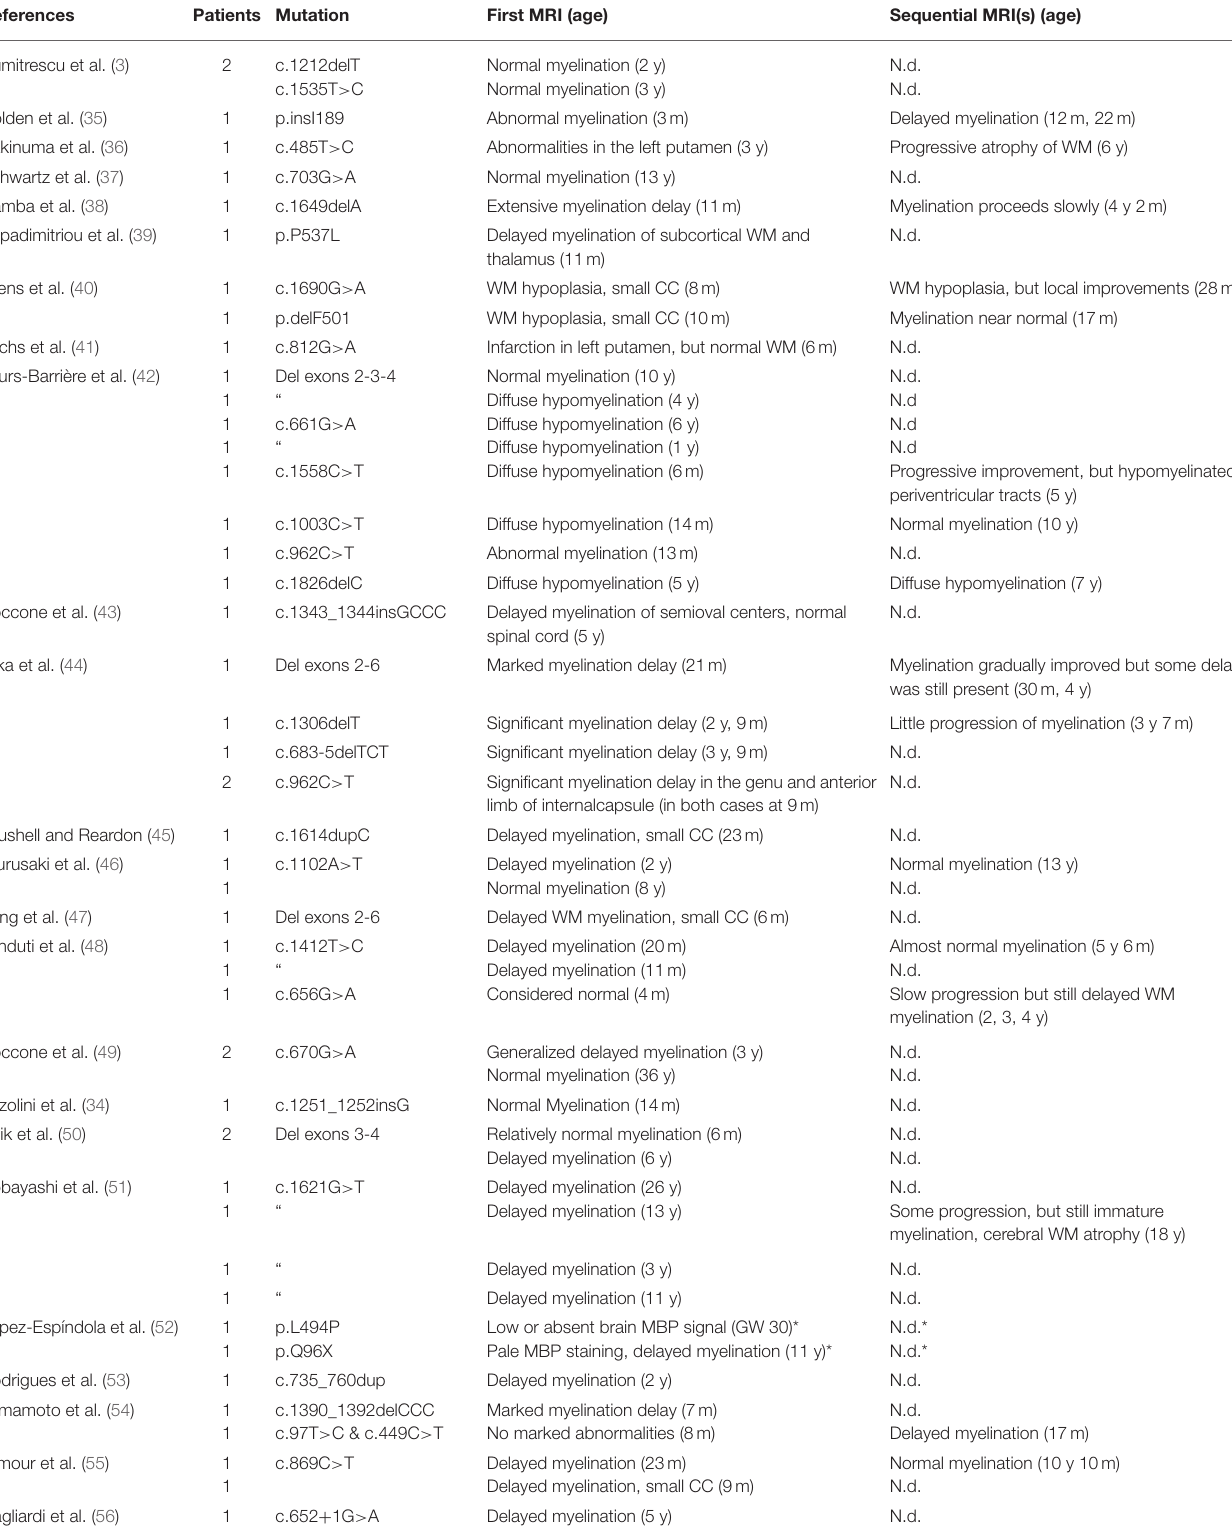
TABLE 1 | MRI data on case-reports of AHDS patients from October 2004 to December